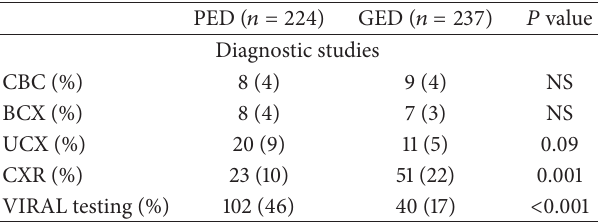
Table 2: Laboratory test performed.